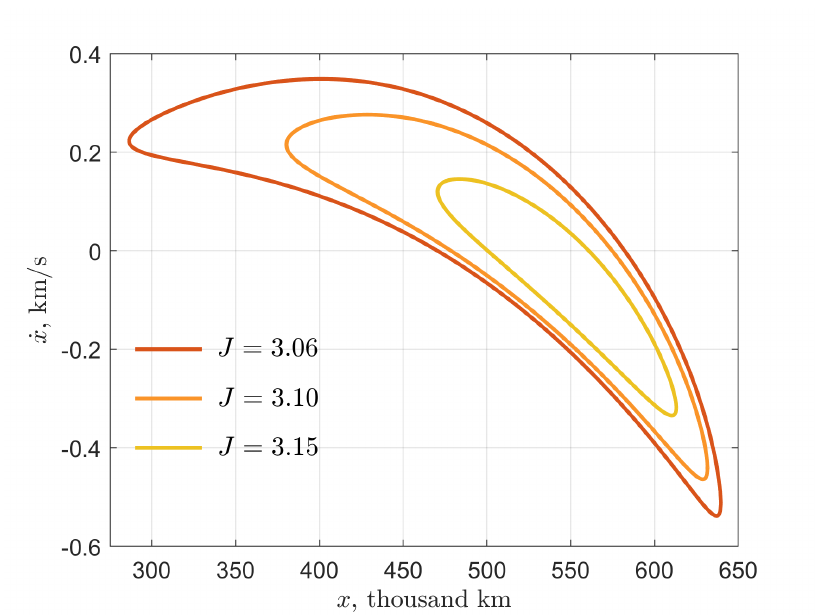
Figure 8. Nested L 2 lunar gateways for different Jacobi integral levels: J = 3.06, J = 3.10, J = 3.15.